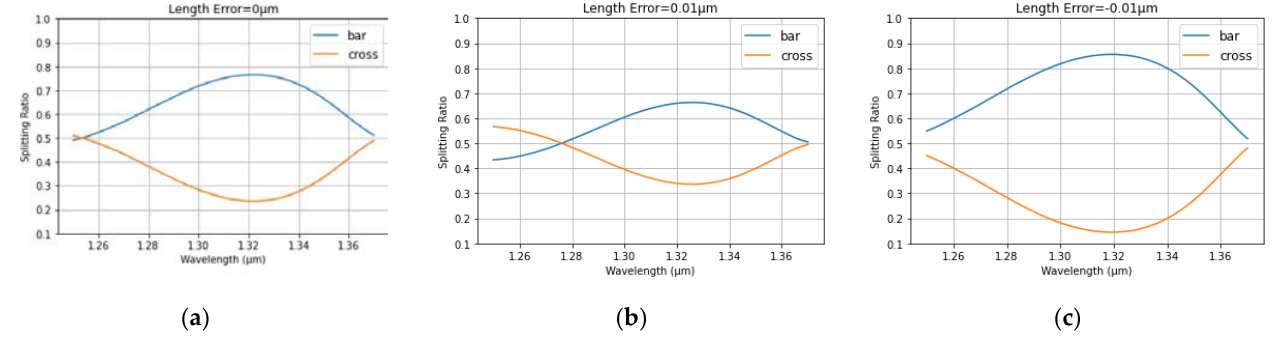
Figure 5. The simulated spectrum response for the bidirectional MZDC ( a ) without the process length shift; ( b ) 10 nm length shift; ( c ) − 10 nm length variation.